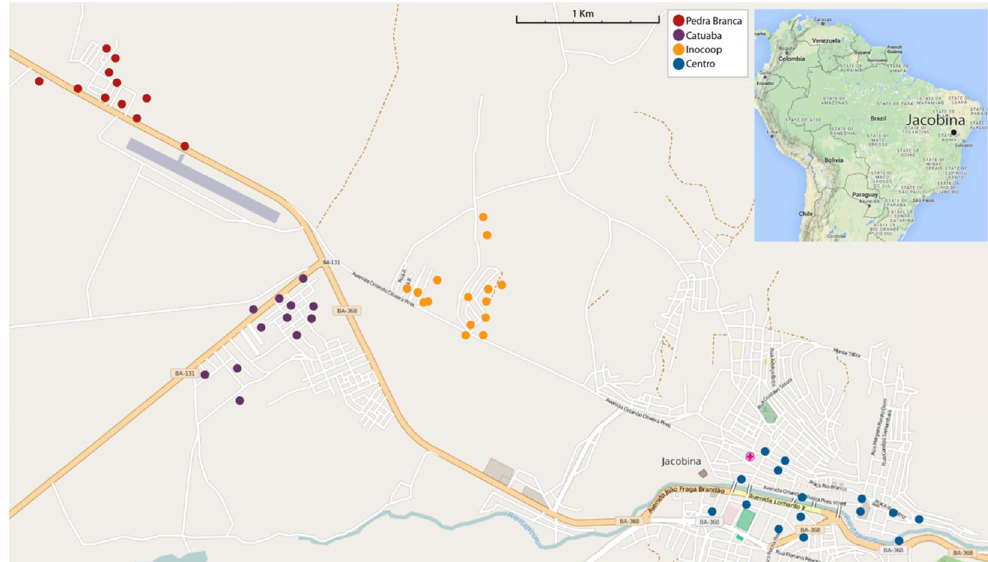
Figure 1. Map of Jacobina. Ovitraps where samples were collected are indicated with colored dots, coded by neighborhood. Releases were made in the neighborhoods of Pedra Branca, Catuaba, and Inocoop but never in the Centro area. © OpenStreetMap